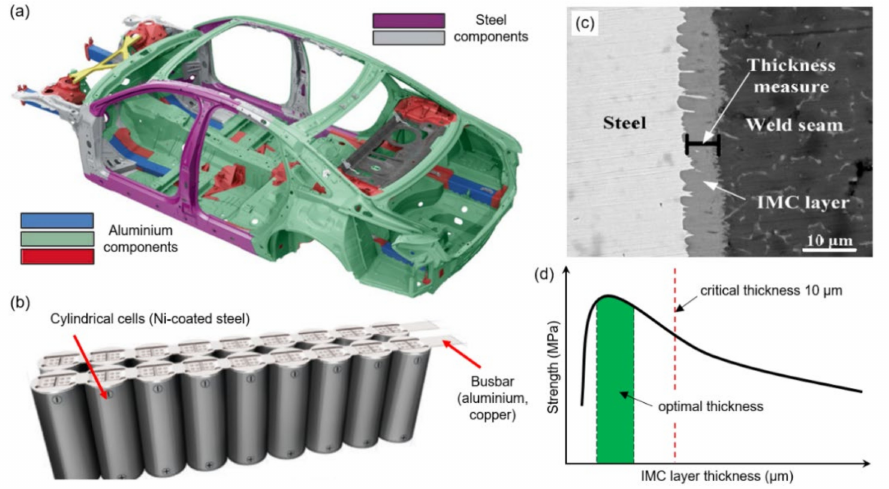
Figure 1. ( a ) Typical application of dissimilar materials in various industries, where Audi A8 is presented as an example and ( b ) battery pack made of cylindrical cells; modified and based on [10,11]. ( c ) Typical outlook and features of IMC layer by scanning electron microscope, from [7]. ( d ) Effect of IMC layer thickness on strength